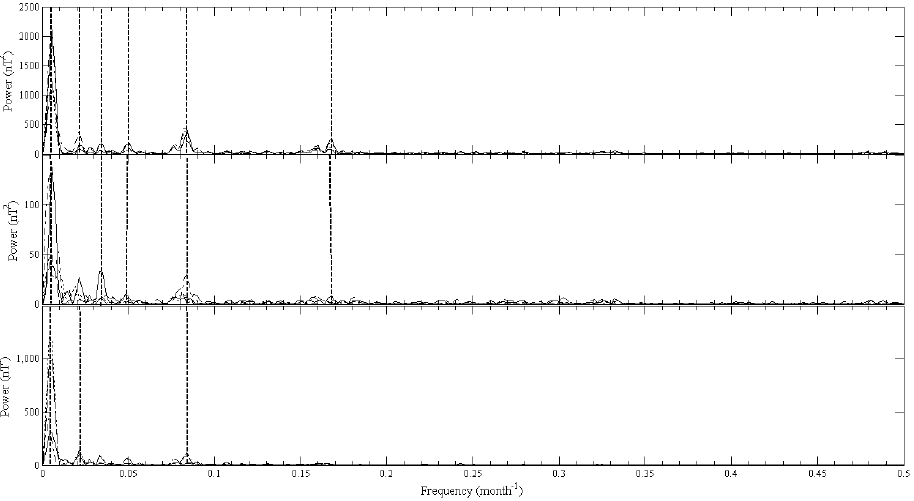
Figure 17. Power spectrum of X, Y, Z - components of external contribution (CM5 model) at different observatories: NGK (dotted line), FUR (dashed line) KAK (dash-dotted line) and HER (solid